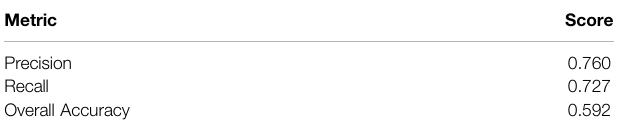
TABLE 1 | Summary of detection performance